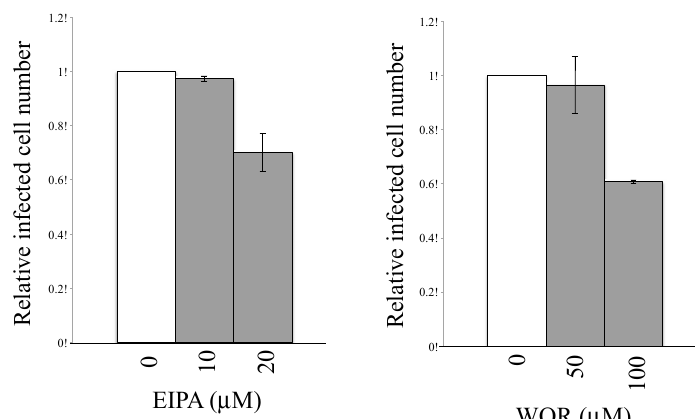
Figure5. TreatmentwithmacropinocytosisinhibitorsafterCHIKV-pseudotypedMLVvectorinoculation inhibits its infection less e ffi ciently than treatment before inoculation. TE671 cells were inoculated with Figure 5. Treatment with macropinocytosis inhibitors after CHIKV-pseudotyped MLV vector CHIKV-pseudotyped MLV vector, and cultured for 5 h. The inoculated cells were treated with EIPA or inoculation inhibits its infection less efficiently than treatment before inoculation. TE671 cells were WOR for 5 h. Blue cell numbers in DMSO-treated cells were always set to 1. Relative values to the blue cell numbers detected in the cells treated with the same volume of DMSO are indicated. This experiment was repeated in triplicate, and averages are shown. Error bars indicate standard